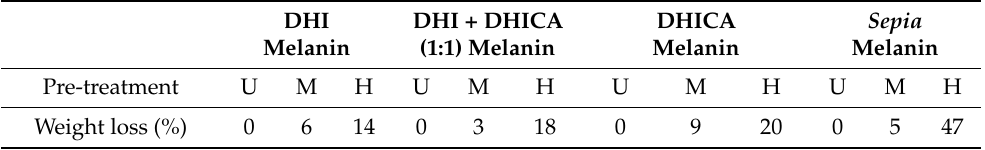
Table 1. List of samples used in this study, together with recorded weight losses during our artificial maturation experiments. Abbreviations: U, untreated; M, mild maturation (100 ◦ C/100 bar for 24 h); H, harsh maturation (250 ◦ C/250 bar for 72 h).